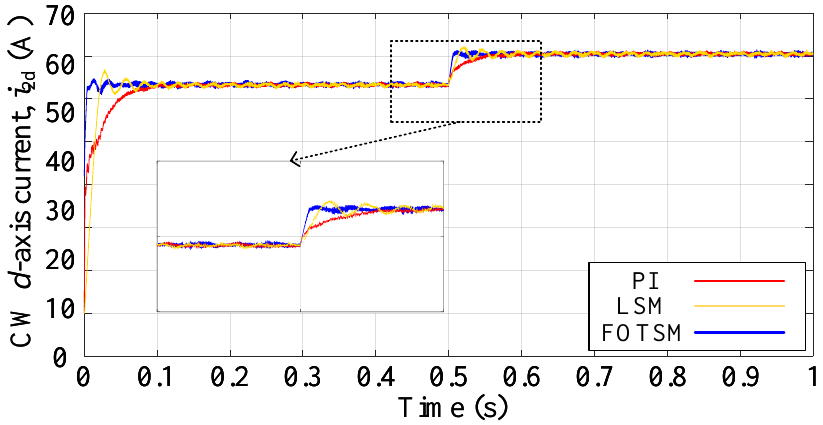
Figure 8. The CW d -axis current responses under PI, LSM, and FOTSM during the load adding